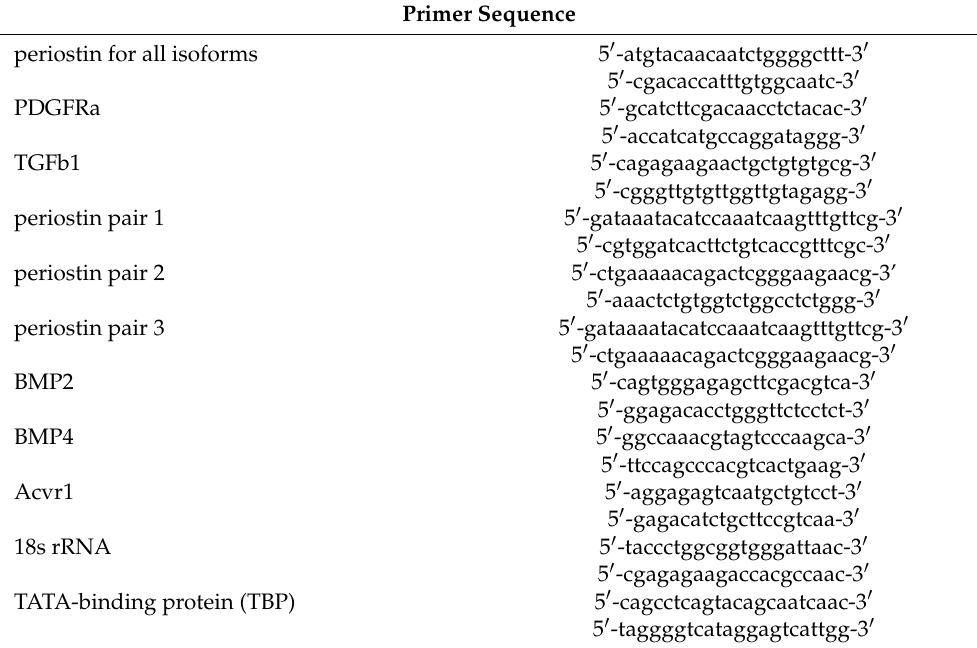
Table 2. Summary of primer